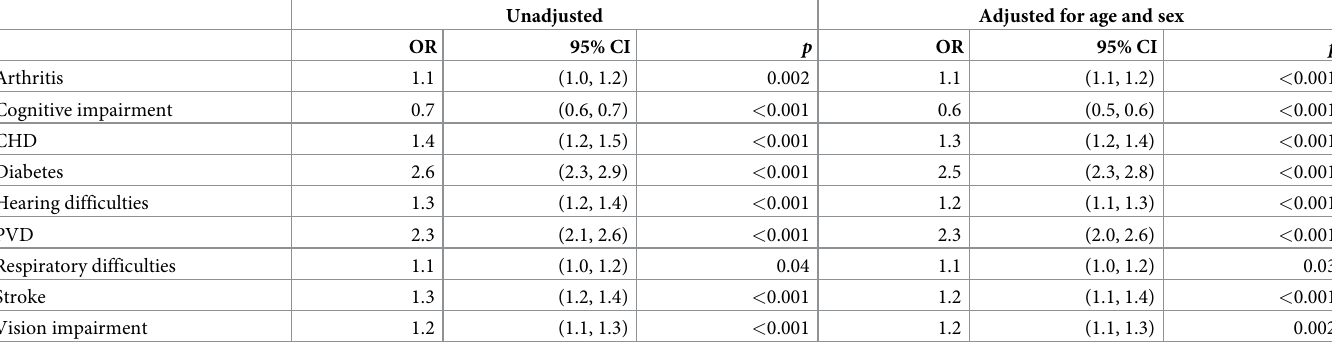
CFAS, Cognitive Function and Ageing Study; CHD, coronary heart disease; CI, confidence interval; OR, odds ratio; PVD, peripheral vascular